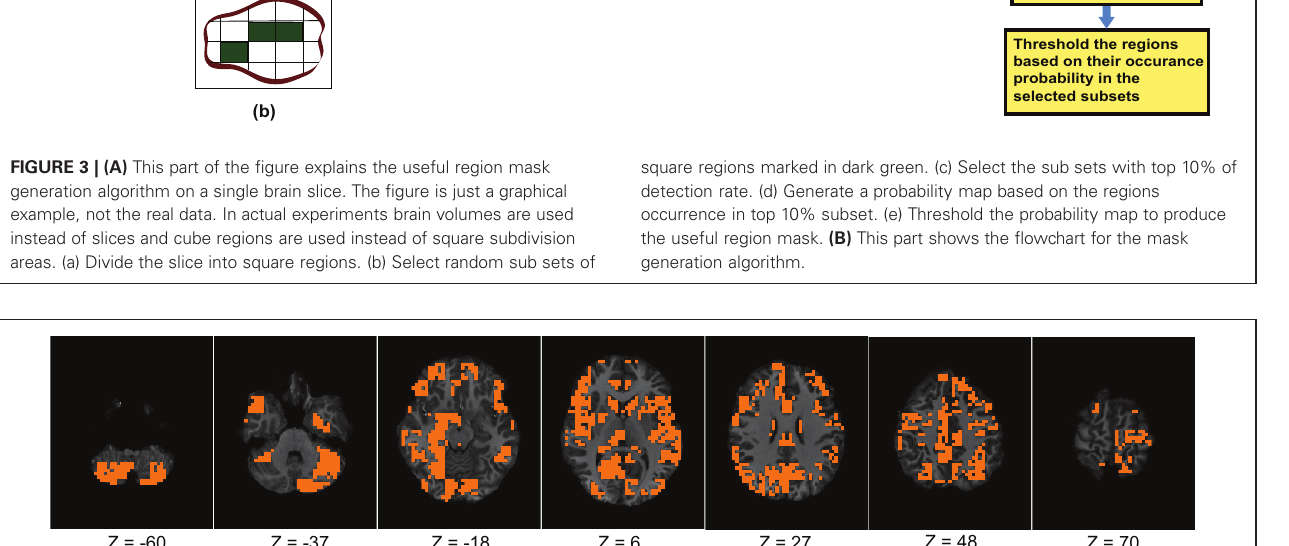
FIGURE 4 | The figure shows different slices to demonstrate the useful region mask computed. The masked regions are highlighted in orange color and overlaid on the structural images of a sample subject.